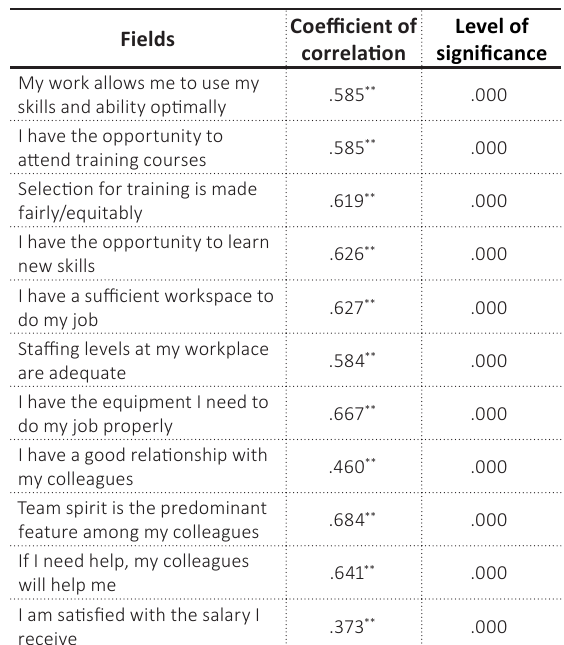
Table 5 (cont.). Person correlation test for job satisfaction